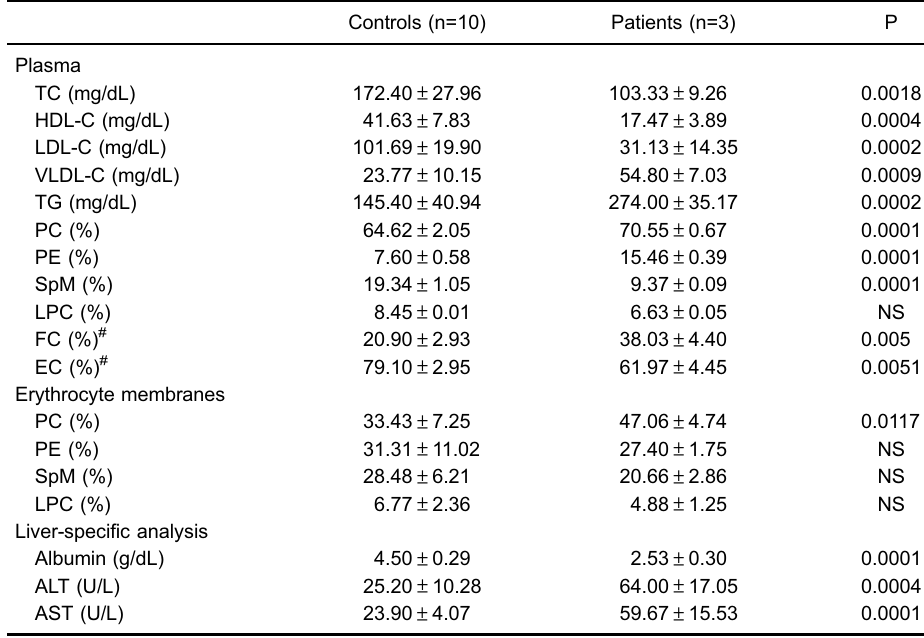
Table 1. Lipid composition of plasma and erythrocyte membrane and biochemical analysis of liver function of control subjects and patients with